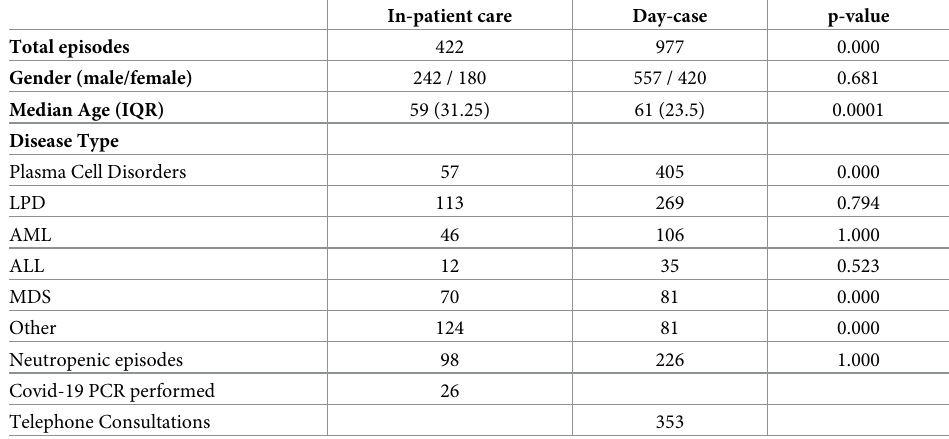
Table 1. Clinical and demographic characteristics of total episodes (n = 1399) reviewed during the study